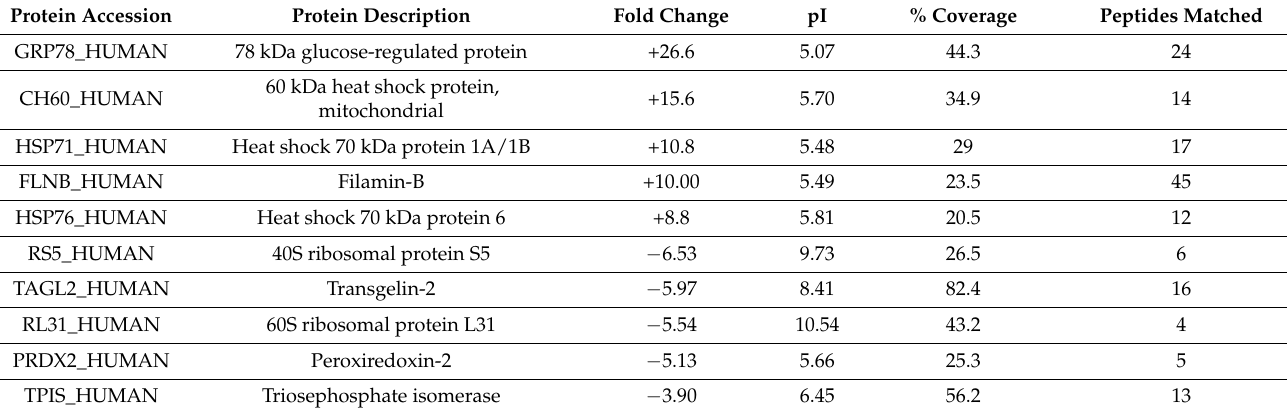
Table 2. List of top differentially expressed proteins (up and down) in AGS cells treated with OAEO.